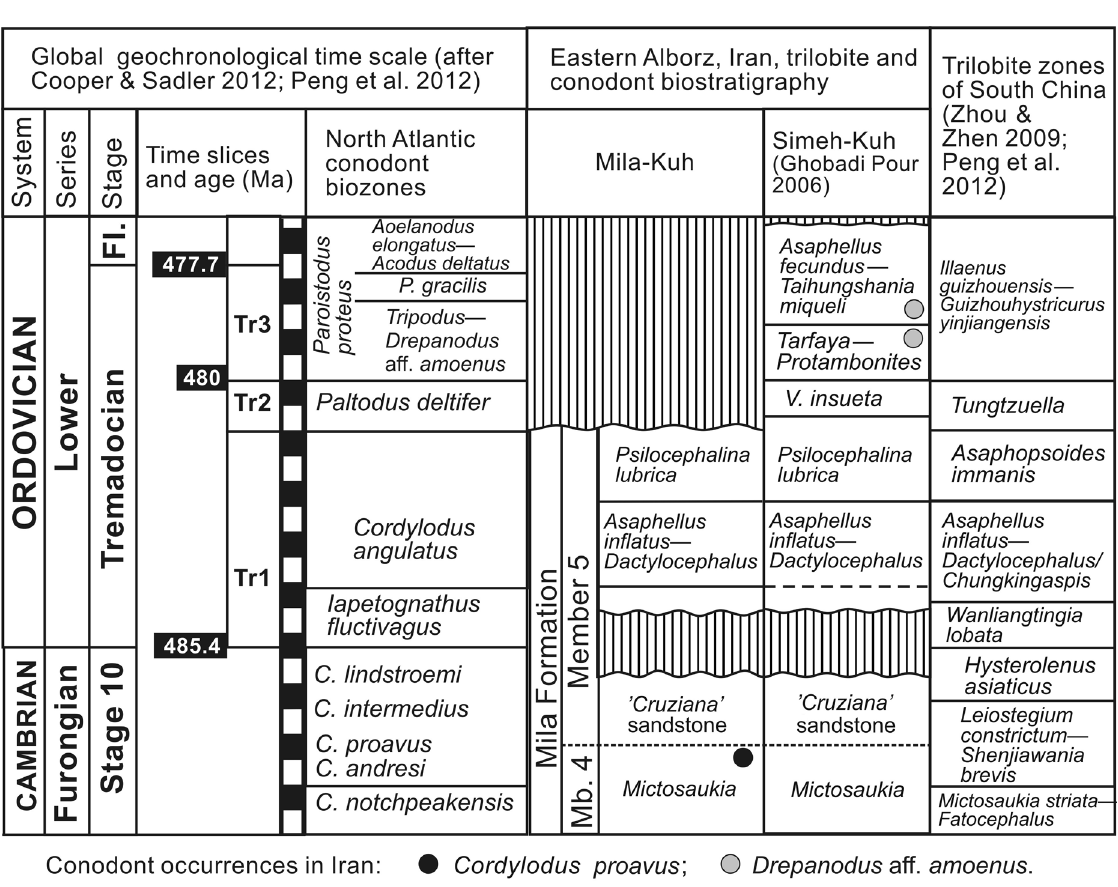
Fig. 3. Summarized chrono- and lithostratigraphical chart of the uppermost Cambrian to Lower Ordovician (Tremadocian) strata of eastern Alborz showing correlation with the biostratigraphical trilobite succession of South China. North Atlantic conodont biozones are mainly after Kaljo et al. (1986), Viira (2011) and Männik & Viira